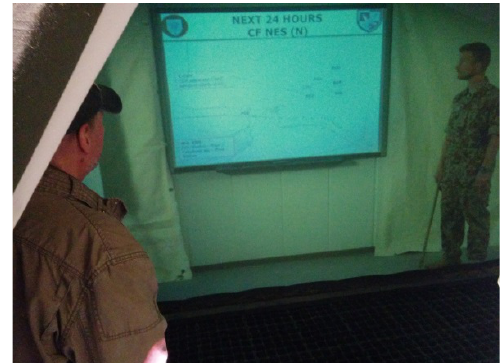
Figure 10. A video projection on the inner backdrop of a tent situates the museum visitor among Danish UN forces in Afghanistan. Tøjhusmuseet, Denmark.